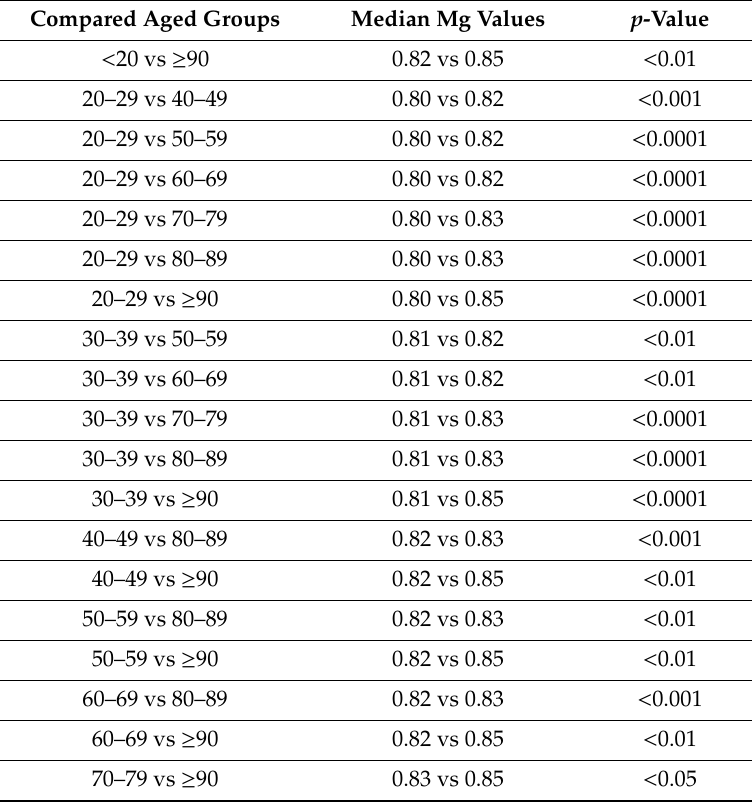
Table 1. Statistical di ff erences in median magnesium concentration among studied aged groups (Kruskal–Wallis